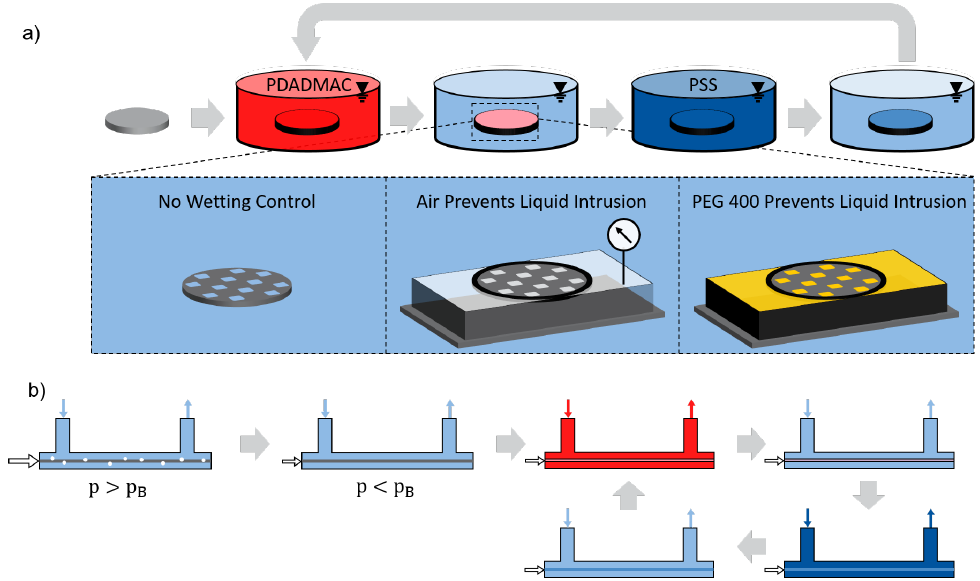
Figure 1. Schematic setup used for polyelectrolyte deposition. ( a ) Static coating of flat isoporous sup- ports. Alternating dip-coating of samples leads to successive polyelectrolyte deposition. Isoporous supports without any periphery, supports sealed to an air-filled compartment with 10 mbar excess pressure, and supports sealed to a compartment filled with PEG400 were dip-coated. ( b ) Dynamic coating of a heterogeneous hollow fiber support. Air flows through the lumen at a pressure level p > p B , while the module is filled with water. The gas pressure is reduced until p < p B . Polyelec- trolyte coating solutions and rinsing solutions are alternatingly pumped through the shell side of the